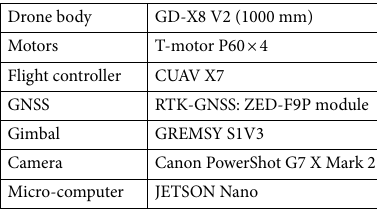
Table 1. Drone specifications.